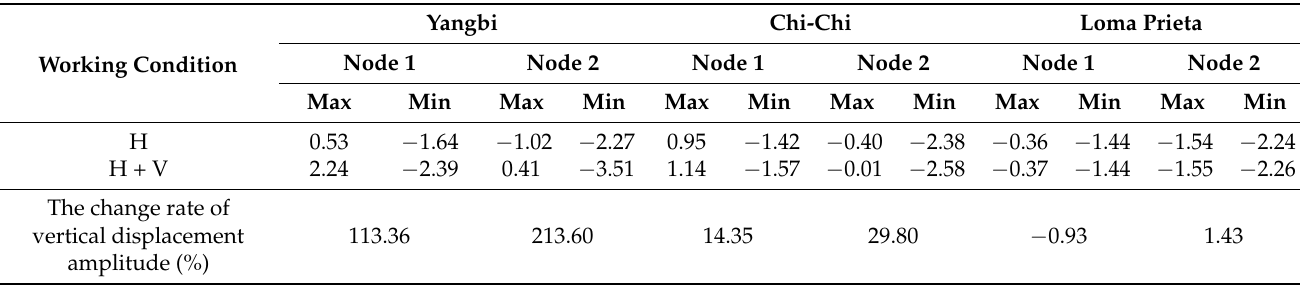
Table 3. Peak displacement of the top layer in the UD direction/mm.